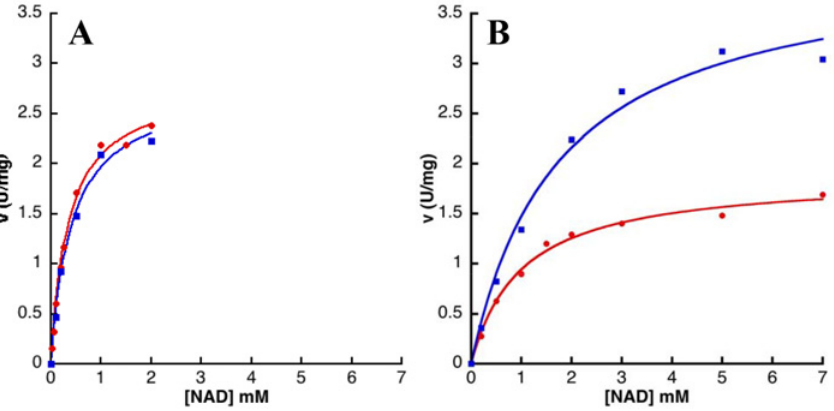
Fig 3. IMPDHbt (A) and IMPDHlpp (B) activities versus NAD concentration. Enzyme activity was determined at a fixed concentration of IMP (1 mM for IMPDHbt and 2 mM for IMPDHlpp), and in the absence (red curve) or in the presence (blue curve) of 5 mM MgATP. The curves correspond to the fit of the experimental data to the Michaelis-Menten equation and the calculated parameters are displayed in Table 4.